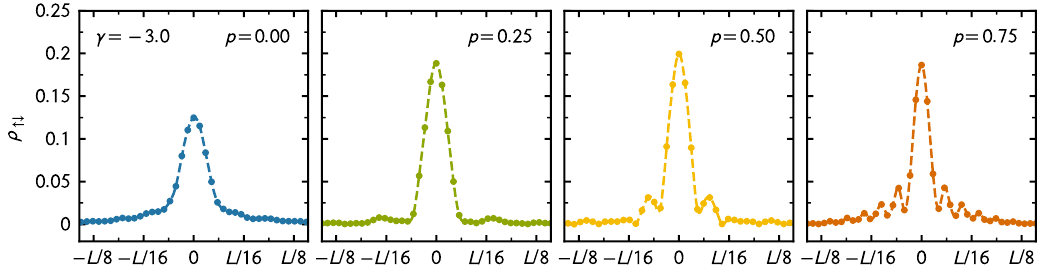
Figure 2: On-site pair-correlation function for systems of fixed density n = 0.4 and polarizations of p = 0.0,0.25,0.5 and 0.75 (from left to right). The “oscillatory behavior” with increasing polarization is clearly visible. Note that the envelope of the correlation functions obeys a power-law behavior for large r . The statistical error bars are smaller than the symbol